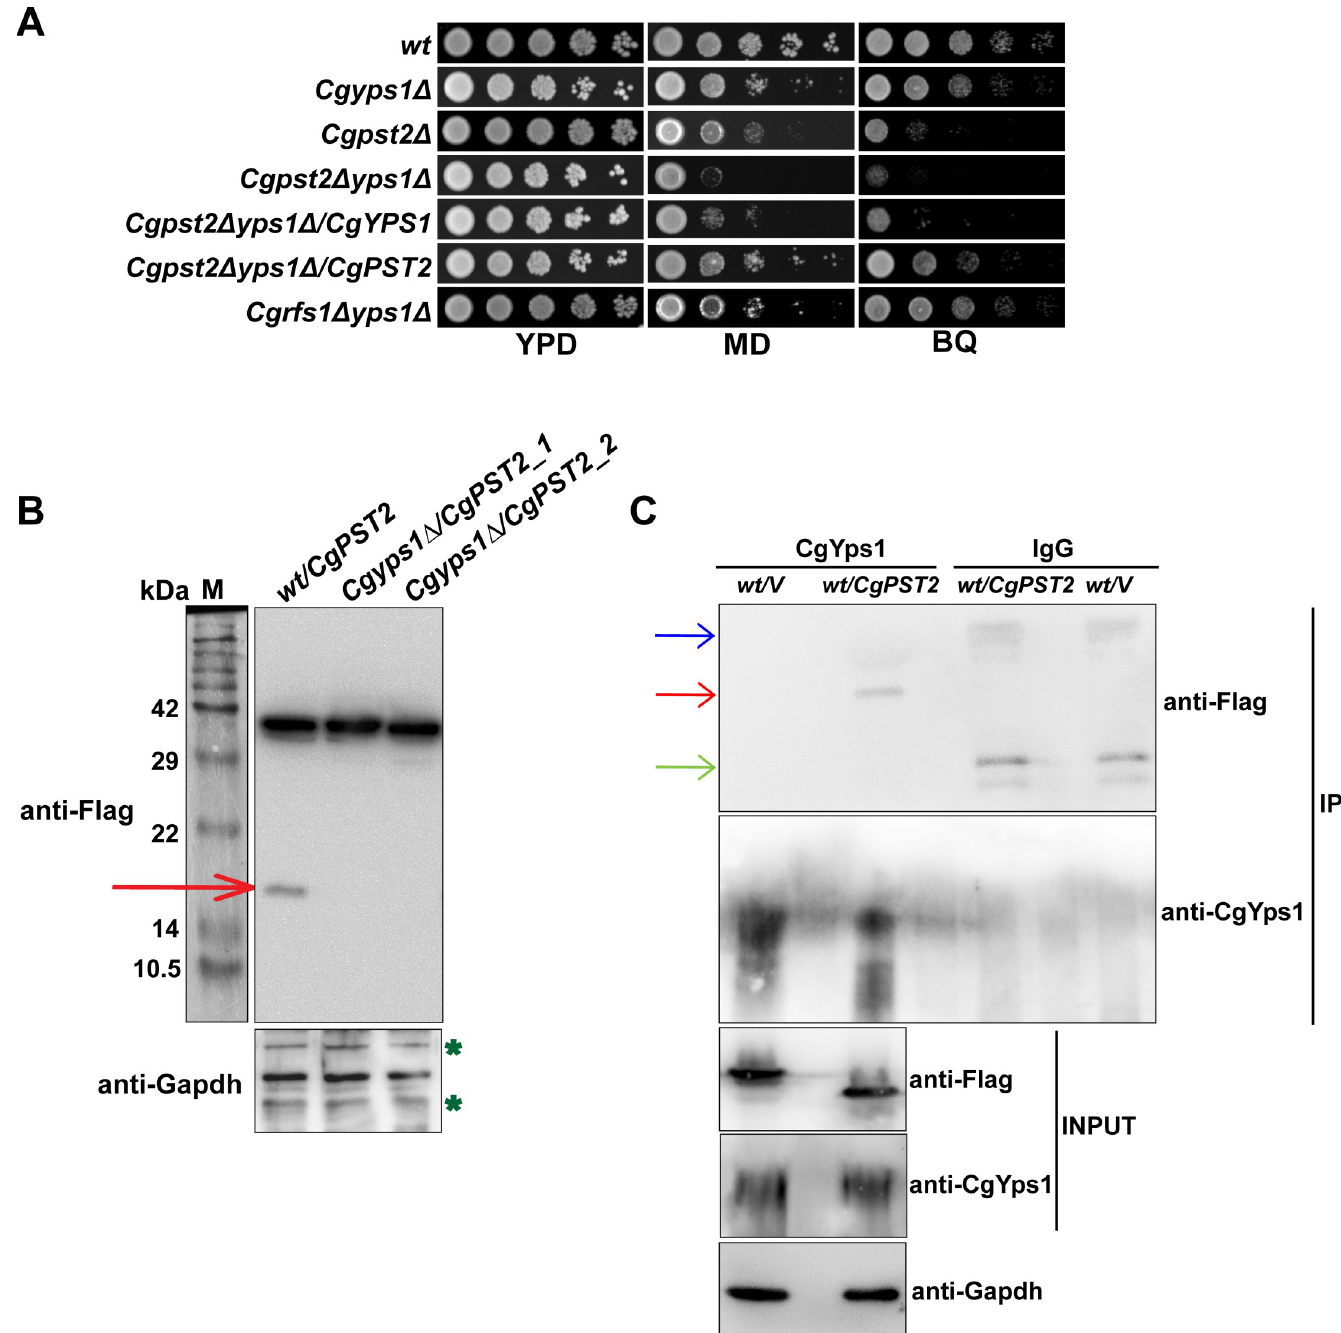
Fig 2. CgPst2 interacts with CgYps1. A. Serial dilution spotting assay illustrating MD (95 μ M) and BQ (4 mM) sensitivity of indicated CgYPS1 -deleted strains. B. Immunoblot analysis of CgPst2-SFB in cell extracts (60 μ g) of wt and Cgyps1 Δ transformants expressing CgPST2-SFB . The red arrow marks the small (~ 16 kDa) cleaved fragment of CgPst2. Cgyps1 Δ /CgPST2_1 and Cgyps1 Δ /CgPST2_2 represent two independent Cgyps1 Δ transformants. M, Protein Marker. C. Immunoblot analysis of CgPst2-CgYps1 interaction. Lysates (3.0 mg) of wt cells expressing either SFB-GFP or CgPst2-SFB were immunoprecipitated with anti-CgYps1 or anti- mouse immunoglobulin G (IgG) antibody, resolved on 4–20% polyacrylamide gradient, 12% polyacrylamide and 12% polyacrylamide gels for CgYps1, CgPst2-SFB and CgGapdh, respectively, and were probed with anti-CgYps1, anti-Flag and anti-Gapdh antibodies. CgGapdh was used as loading control. Please note that for Input samples, 200, 75 and 75 μ g protein was loaded for detection of CgYps1, CgPst2-SFB and CgGapdh proteins, respectively. Red, blue and green arrows mark the CgPst2-SFB, Ig heavy chain and Ig light chain, respectively. ‘ V ’ refers to the vector expressing SFB-GFP protein.